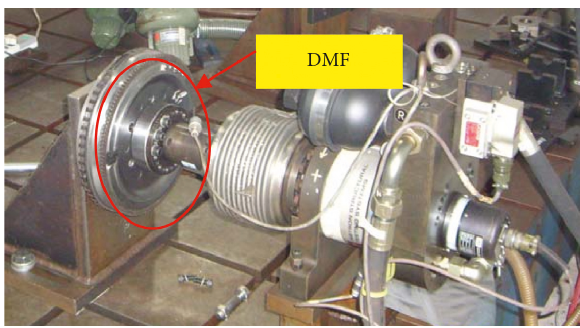
Figure 9: DMF test Table 1: Parameters of DMF.